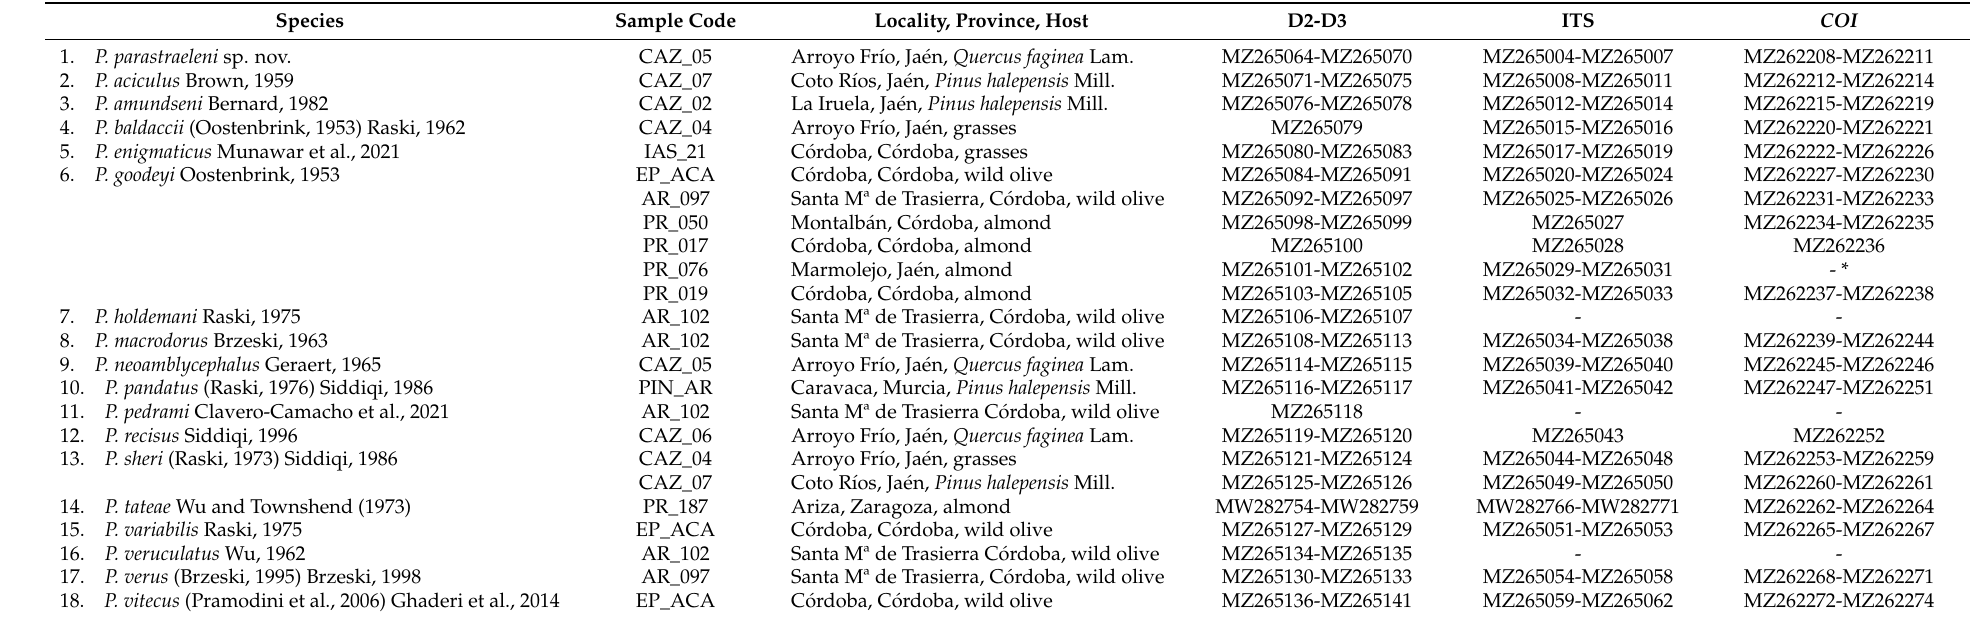
Table 1. Isolates sampled and sequenced for Paratylenchus spp. from several localities in Spain used in this study. Species Sample